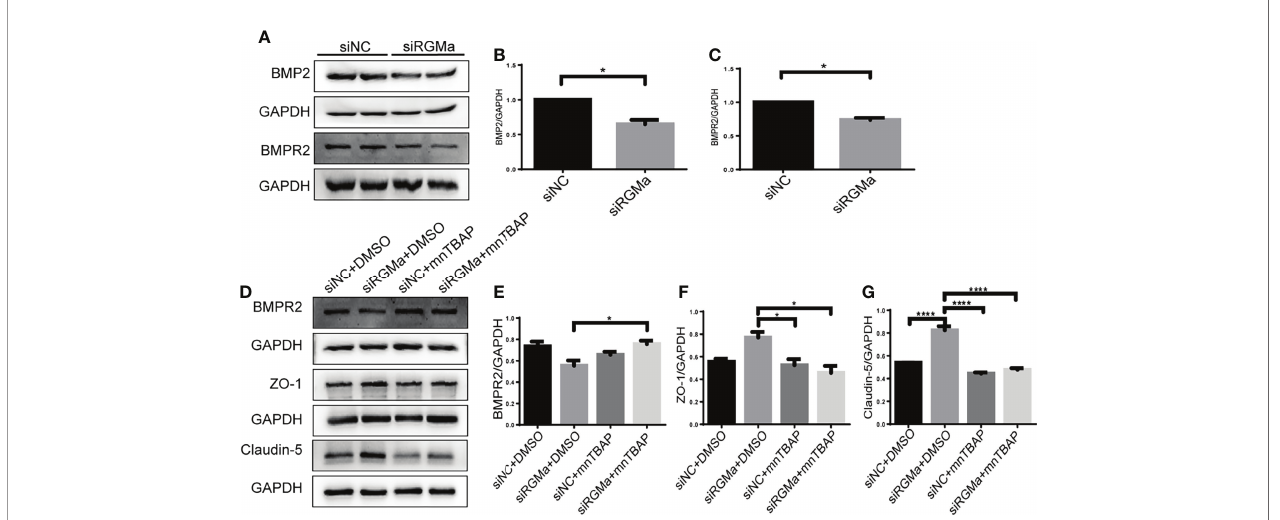
FIGURE 5 | RGMa regulates BMP2 and thereby tight junctional protein expression. (A – C) BMP2 and BMPR II expression were signi fi cantly decreased after RGMa knockdown in vitro BBB ( n = 3, * p < 0.05, t -test). (D – G) After activating BMPR II by mnTBAP 100 µM for 1 h based on inhibiting RGMa, ZO-1 and claudin-5 expression levels were signi fi cantly reduced ( n = 3, * p < 0.05, t -test). ****p <